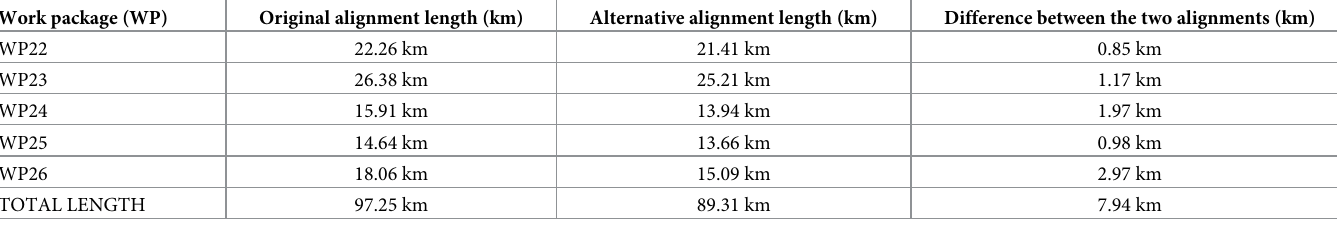
Table 6. Comparison of the Pan Borneo Highways original and alternative alignment lengths. Work package